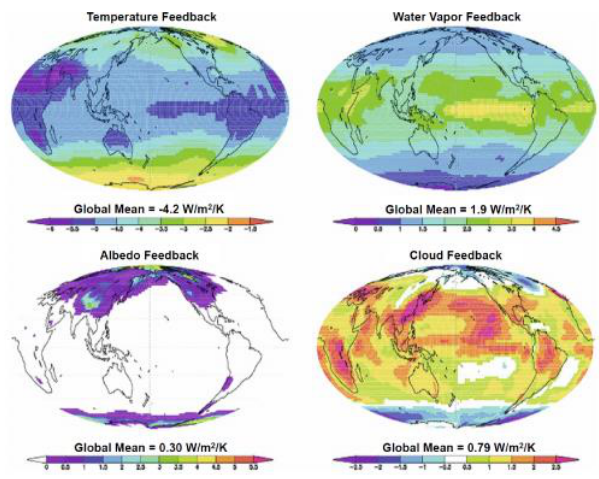
Figure 3. IPCC AR4 Climate Model Feedback Maps